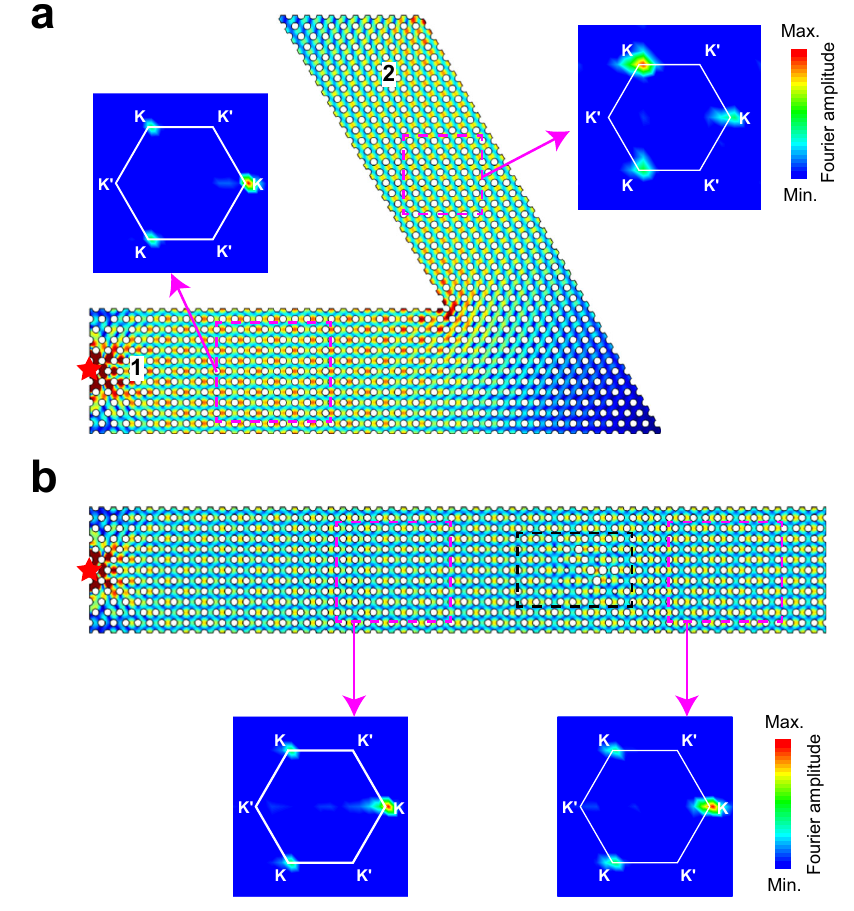
Fig.3|RobustnessoftheCABSsagainstdefects.a , b Simulatedacousticpressure fi eld distributions at 15.5kHz for a point source (red star) on the left of the 120- degree-bend PC and the disordered PC (the cylinder diameters of the 32 units are